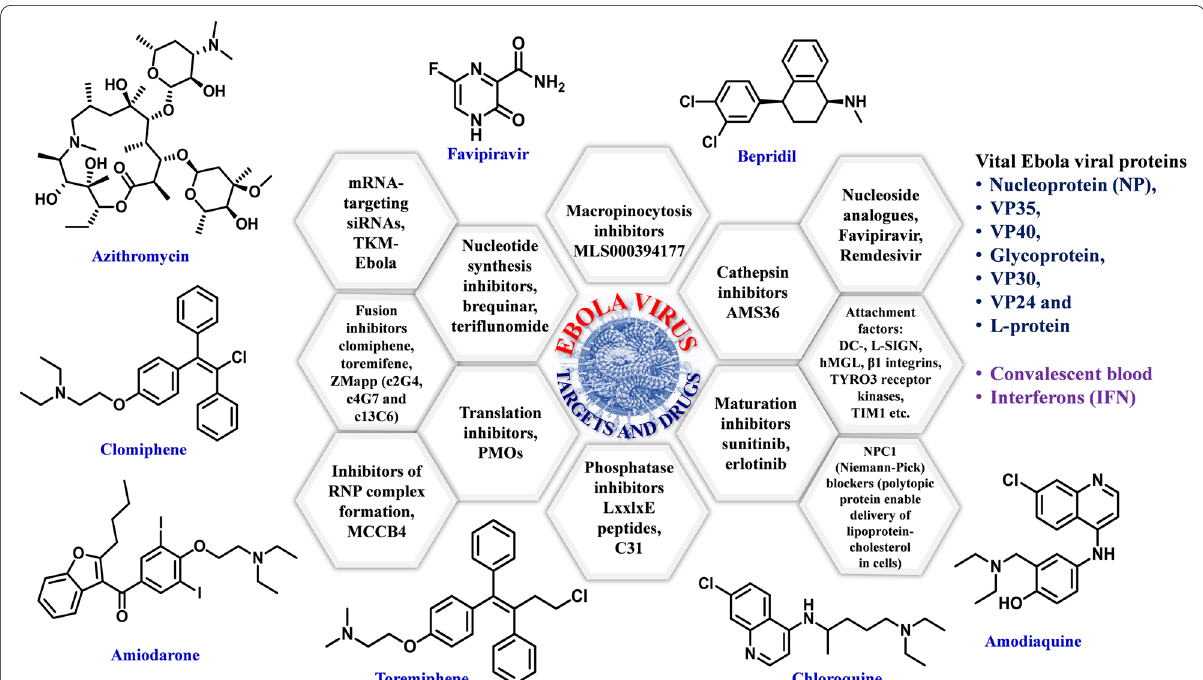
Fig. 4 Characteristic targets and potent drugs against Ebola virus are illustrated as follows: a Targets as macropinocytosis inhibitors MLS000394177; cathepsin inhibitors AMS36; maturation inhibitors sunitinib, erlotinib; phosphatase inhibitors LxxlxE peptides, C31; Translation inhibitors PMOs; Nucleotide synthesis inhibitors, brequinar, teriflunomide; mRNA-targeting siRNAs, TKM-Ebola; Fusion inhibitors clomiphene, toremifene, ZMapp (c2G4, c4G7 and c13C6); Inhibitors of RNP complex formation MCCB4; Nucleoside analogues favipiravir, remdesivir; Attachment factors: DC-, L-SIGN, hMGL, β1 integrins, TYRO3 receptor kinases, TIM1 etc.; NPC1 (Niemann-Pick) blockers (polytopic protein enable delivery of lipoprotein- cholesterol in cells. b Drugs as Azithromycin, Amiodarone, Amodiaquine, Clomiphene, Bepridil, Favipiravir, Toremiphene, Chloroquine; Seven vital ebola viral proteins: Nucleoprotein (NP), VP35, VP40, Glycoprotein, VP30, VP24 and L-protein; Convalescent blood and Interferons